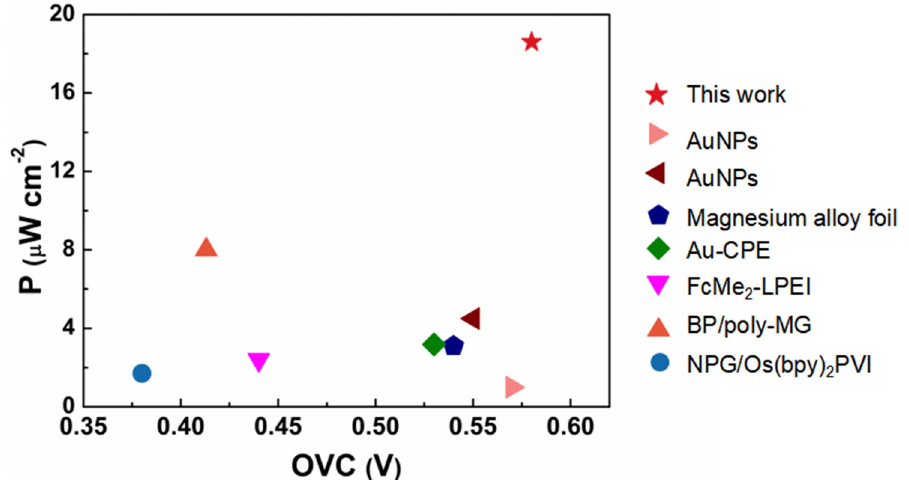
Figure 5. Comparison of tear-based ba tt ery performance over the years based on the information in Table S1 [36–42]. Table S1 [36–42].